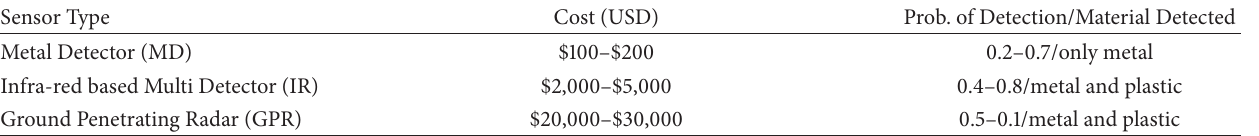
Table 1: Costs of different types of landmine detection sensors in the COMRADE system.